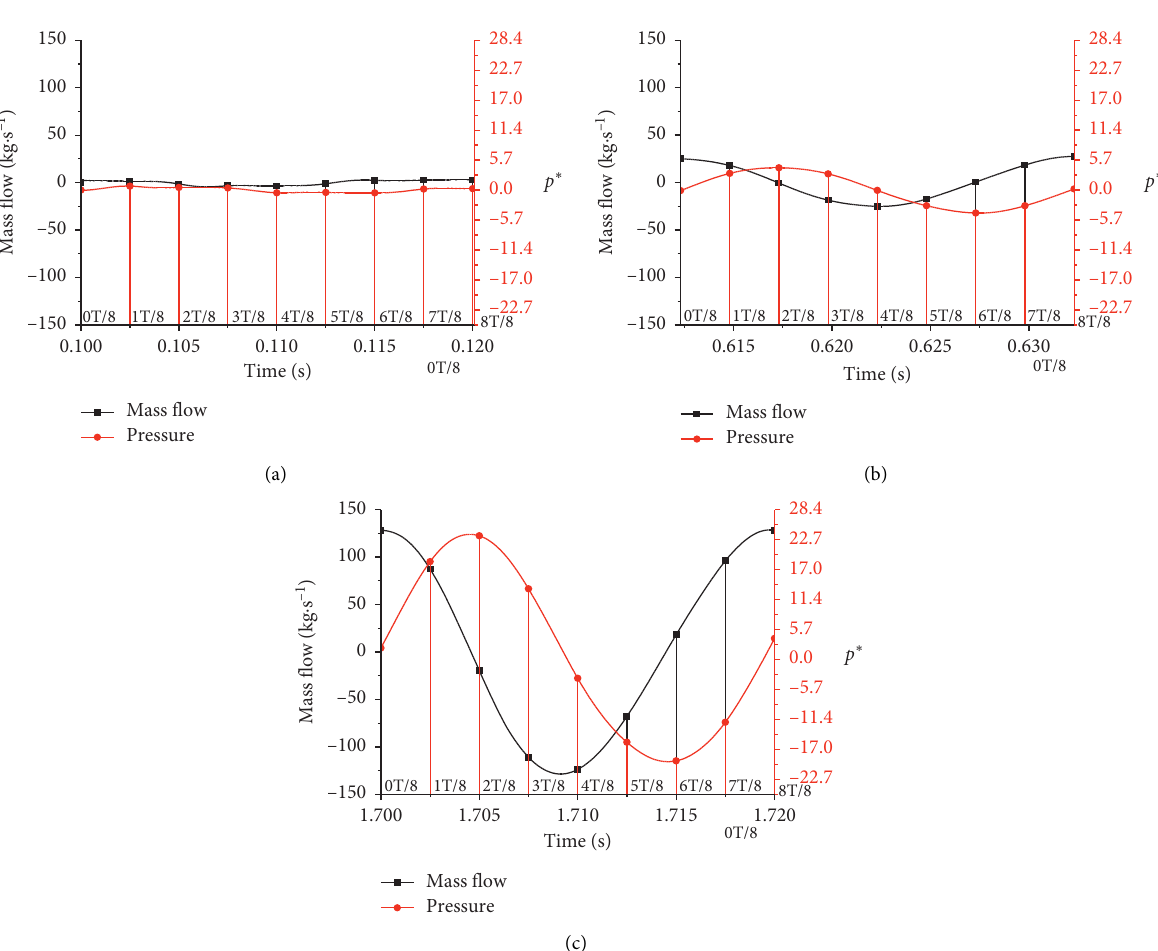
Figure 10: Mass flow rate into branch and pressure of monitoring point p 1 ( v � 40 m/s): (a) t 1 � 0.1 s–0.12s, (b) t 2 � 0.6123s–0.6323s, and (c) t 3 � 1.7s–1.72